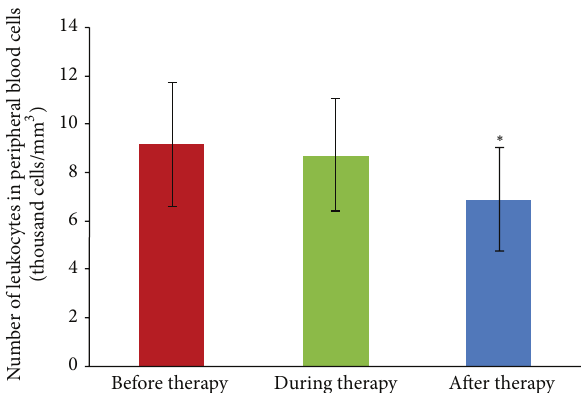
Figure 5: Leukocytosis in patients with infections caused by P. aeruginosa treated with EPT before ( 𝑛 = 10 ), during ( 𝑛 = 8 ), and after the treatment ( 𝑛 = 4 ). The differences were tested using Wilcoxon’s test. ∗ Statistically significant difference between the number of leukocytes in the peripheral blood of patients after EPT and the number of leukocytes before the treatment, Wilcoxon’s